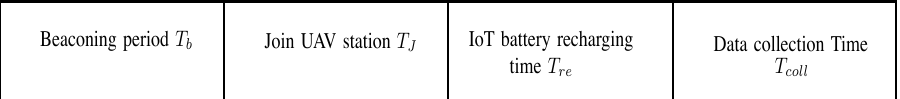
Fig. 1: system model